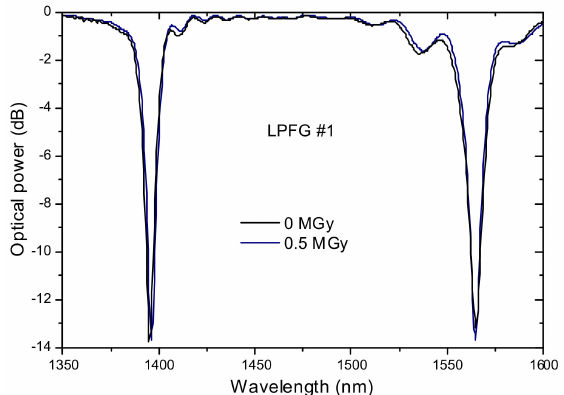
Figure 18. Effect of γ -radiation on an LPFG arc-induced in a pure-silica-core fiber. Adapted with permission from ref. [94]. © 2021 The Optical